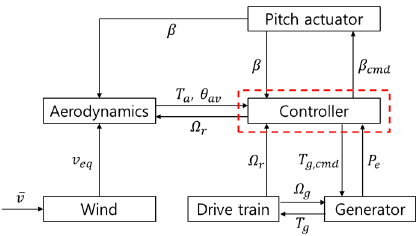
Figure 5. The wind turbine dynamic model.